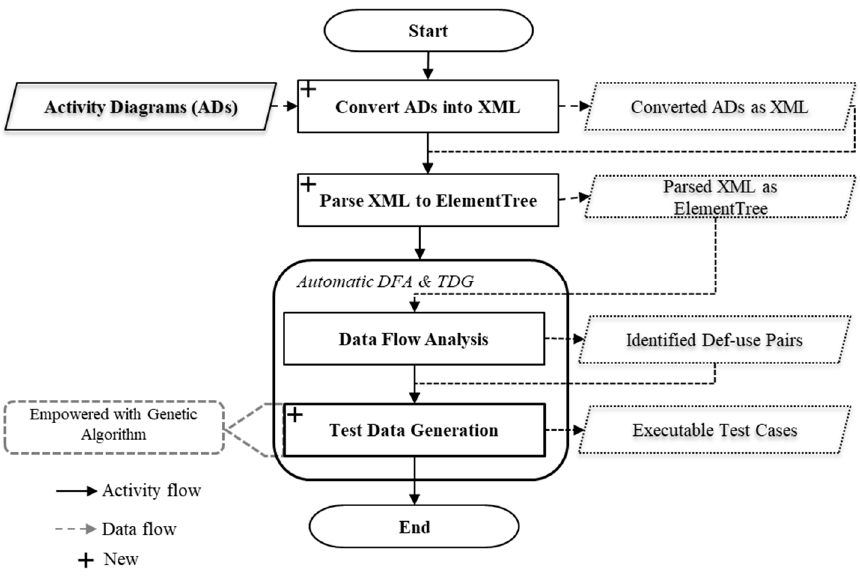
Figure 2. Overview of the major activities in our approach.